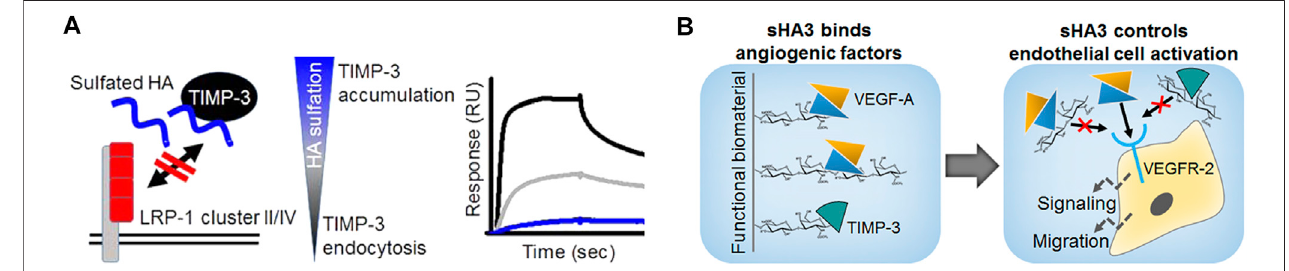
FIGURE 13 | Mechanisms of GAG action on TIMP-3. (A) GAG control ECM remodelling via stabilizing and accruing TIMP-3, interfering with TIMP/LRP-1 complex formation and increasing extracellular TIMP-3 level; SPR sensorgram: binding analysis of solute TIMP-3 with immobilized LRP-1 cluster II in the absence or presence of differentlysulfatedsHA(blackline:interactionofTIMP-3alone,greyandblueline:interactionwithTIMP-3afterpreincubationwithsHA1andsHA3,respectively). (B) GAG control endothelial cell activation by interfering with VEGFR-2 complexation via VEGF-A and TIMP- (Reprinted with permission from Rother S. et al. 2016 Biomacromolecules 17, 3252-3261 and Rother S. et al. 2017 ACS Appl. Mater. Interfaces 9, 9539-9550. Copyright ũ 2016/2017 American Chemical